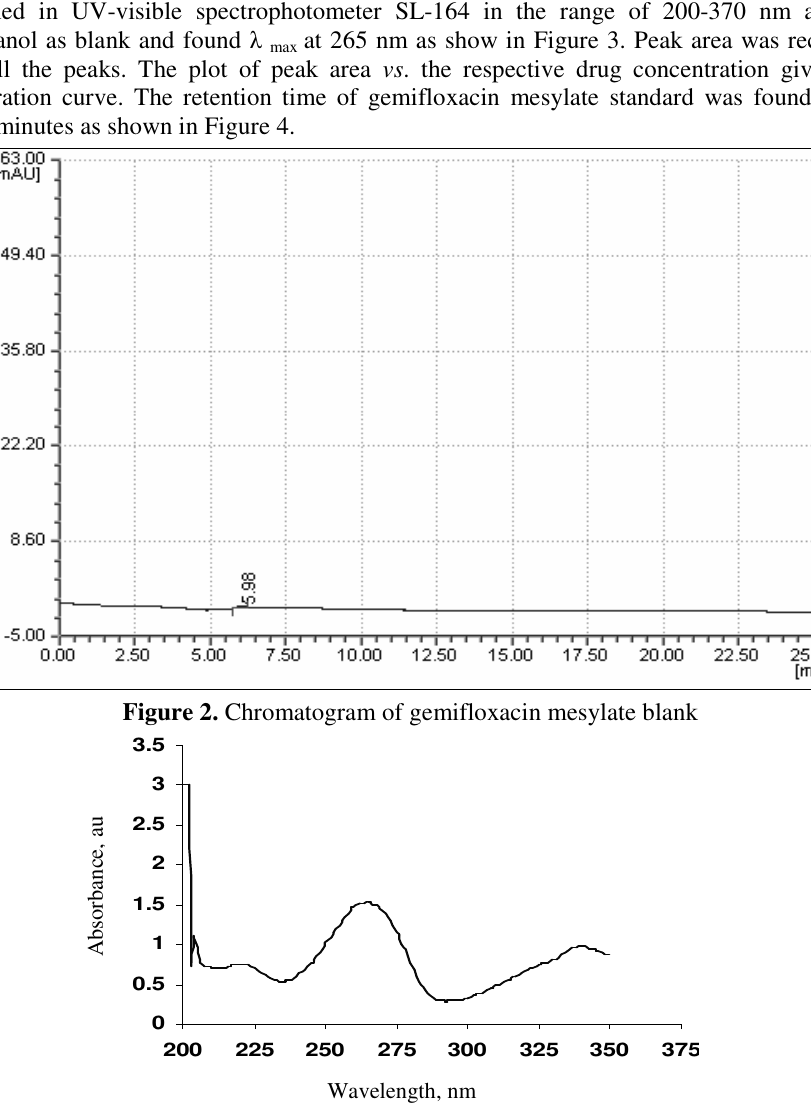
Figure 3. Absorption spectrum of gemifloxacin mesylate (10 µg/mL) in